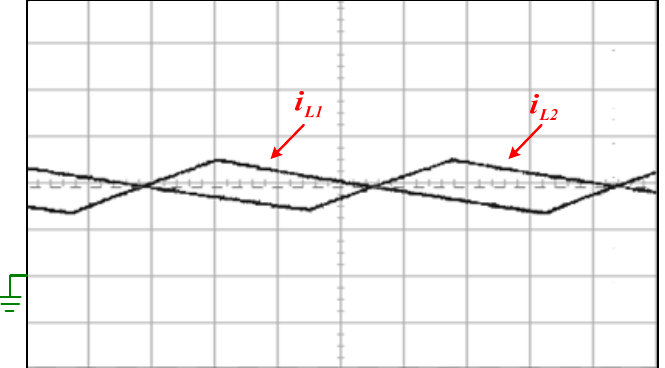
Figure 19. Measured current waveforms of inductors ( L rectifier. i , i : 5 A/div; time: 2 L1 L2